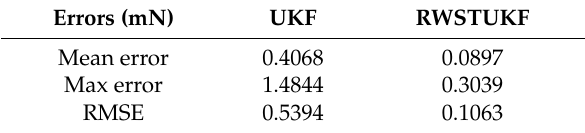
Table 2. Estimation errors by both UKF and RWSTUKF under the error of model simplification.